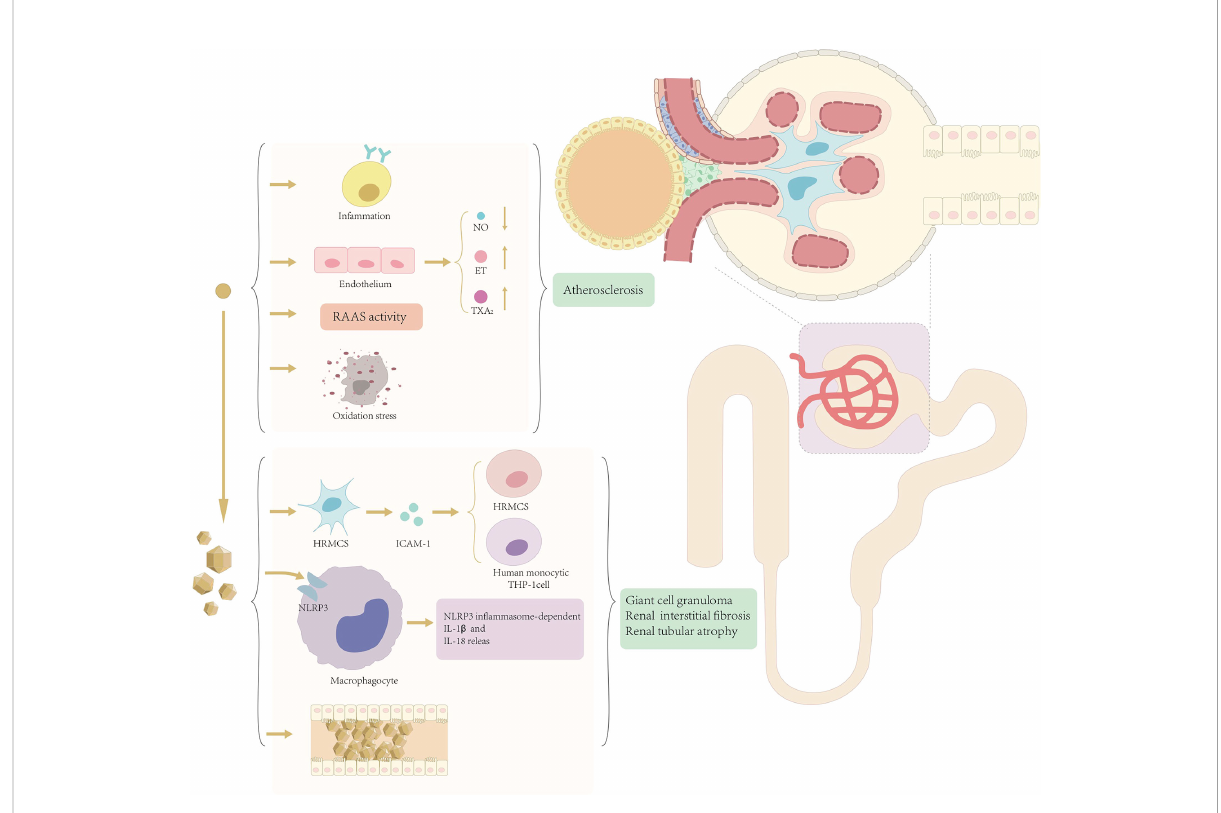
FIGURE 1 Mechanism of renal injury mediated by soluble uric acid and uric acid